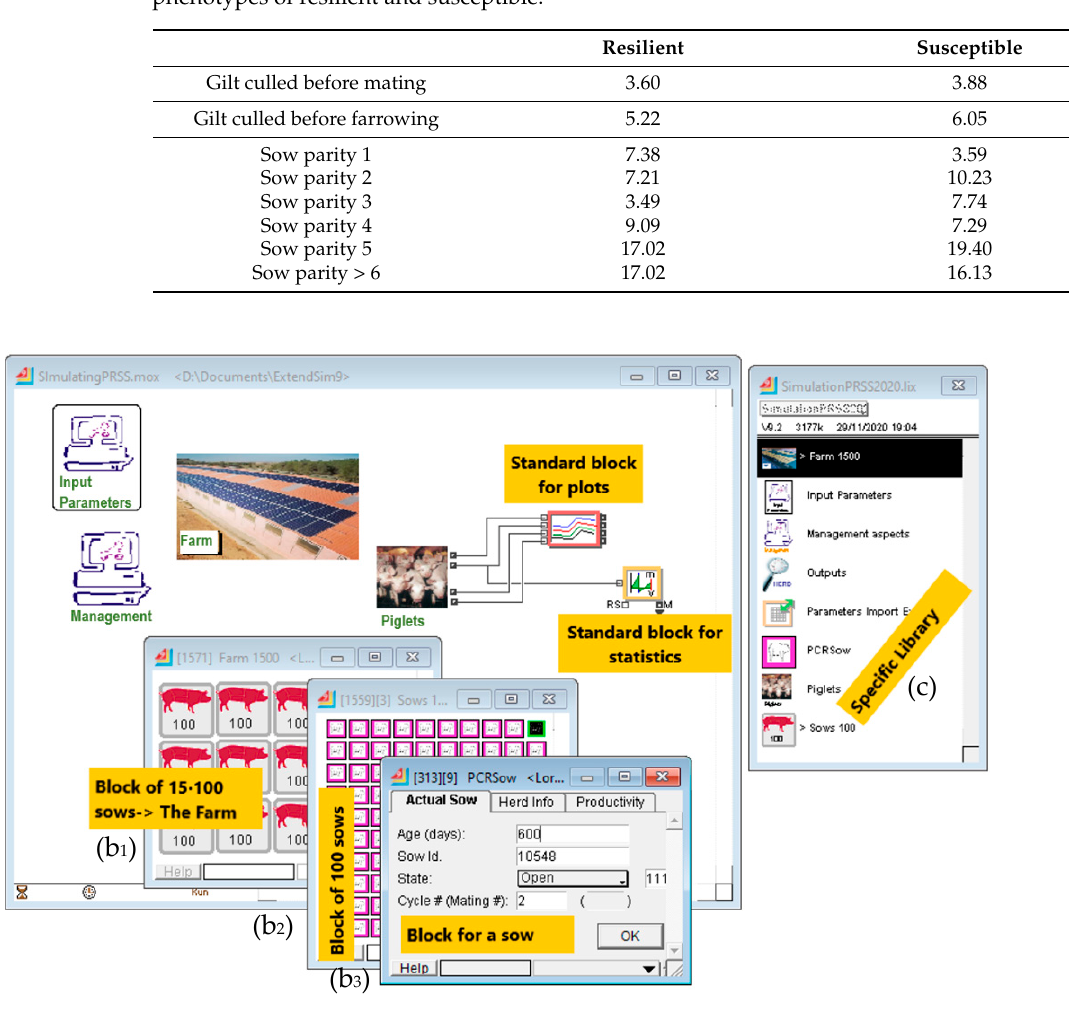
Figure 2. Overview showing ( a ) the model sheet with the main blocks: Input parameters, Management, Piglets, and Farm, besides two standard blocks for plotting and statistics reporting. ( b ) Nested windows illustrate the hierarchy structure of the Farm block ( b 1 ) housing 1500 individual sows grouped into blocks of one hundred ( b 2 ) individual sows ( b 3 ) and ( c ) the library containing the specific blocks of this model.